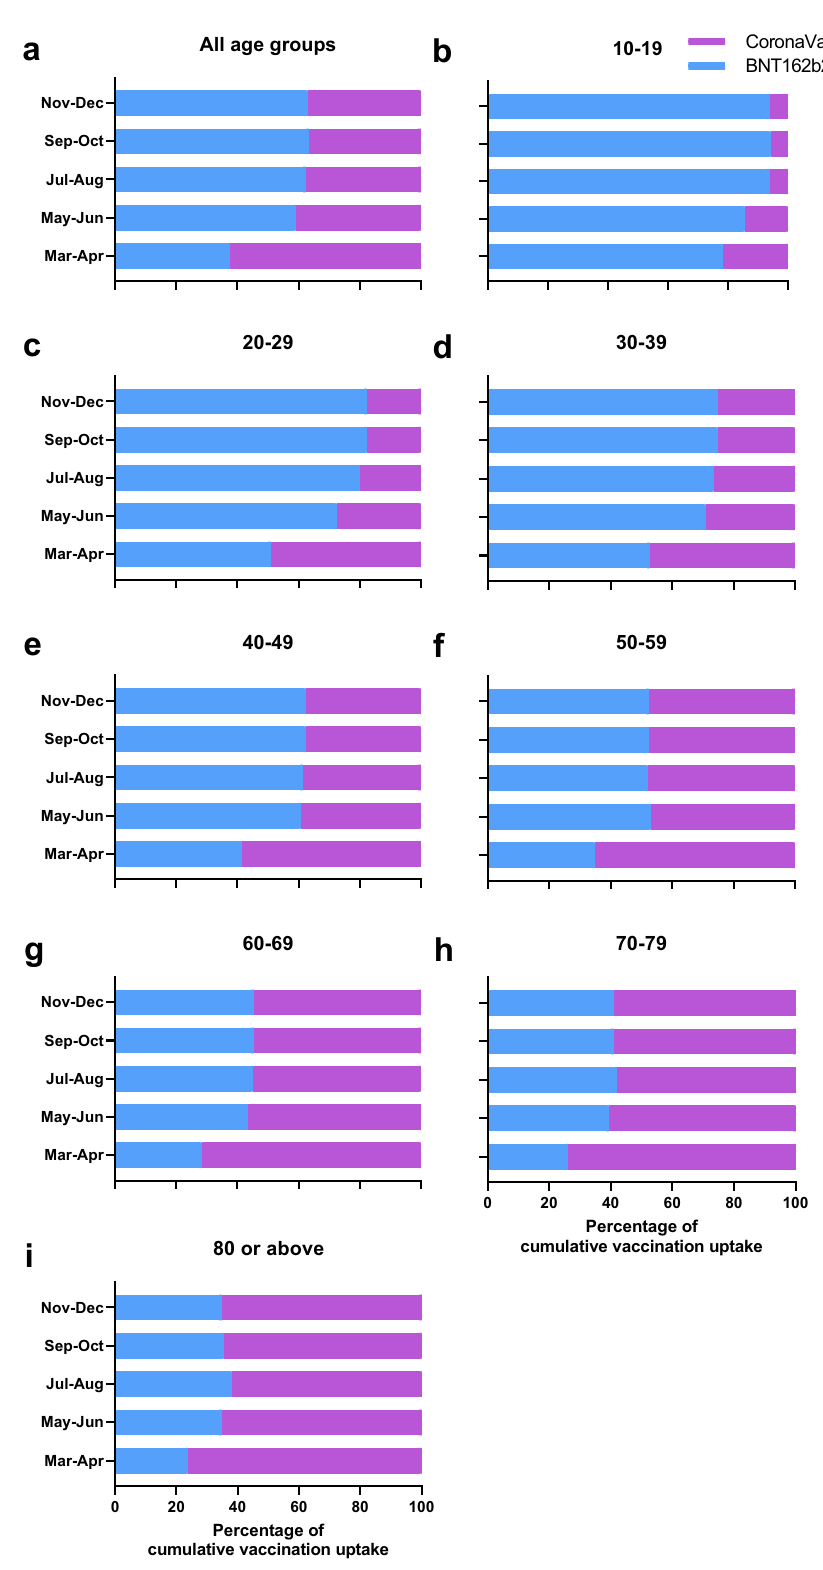
Fig. 2 Percentage of individuals receiving BNT162b2 or CoronaVac in Hong Kong in 2021. a – i Percentage of individuals receiving BNT162b2 or CoronaVac for different age groups. The data were extracted from the website of the Food and Health Bureau of Hong Kong 34 . Source data are provided as a Source Data fi